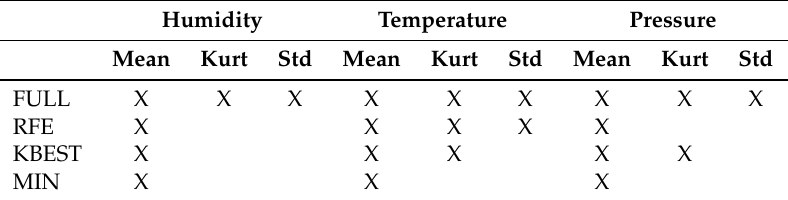
Table 4. Subsets of features for the fitness gym dataset. An X indicates a selected feature.